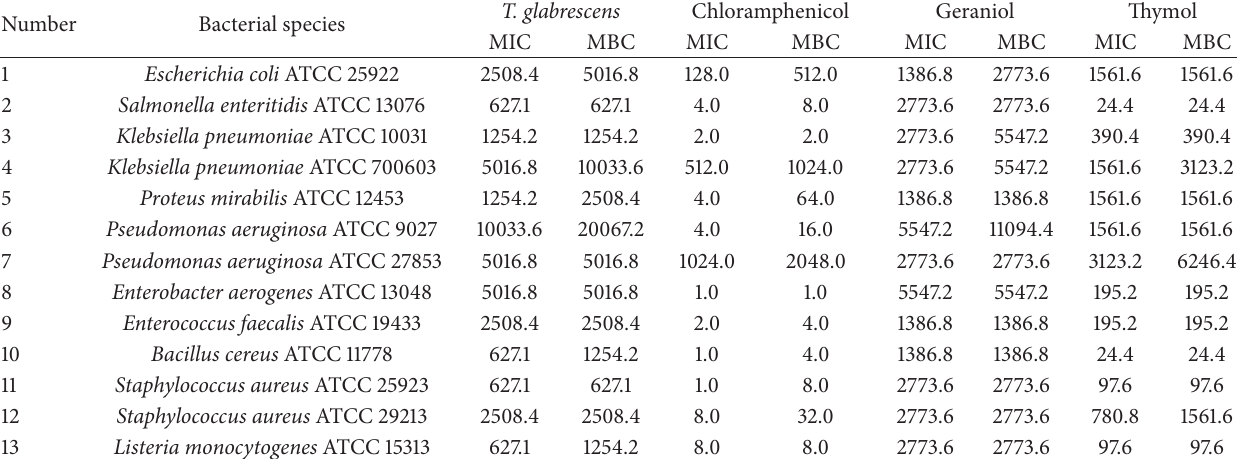
Table 2: Antibacterial activity of T. glabrescens essential oil, chloramphenicol, geraniol, and thymol ( 𝜇